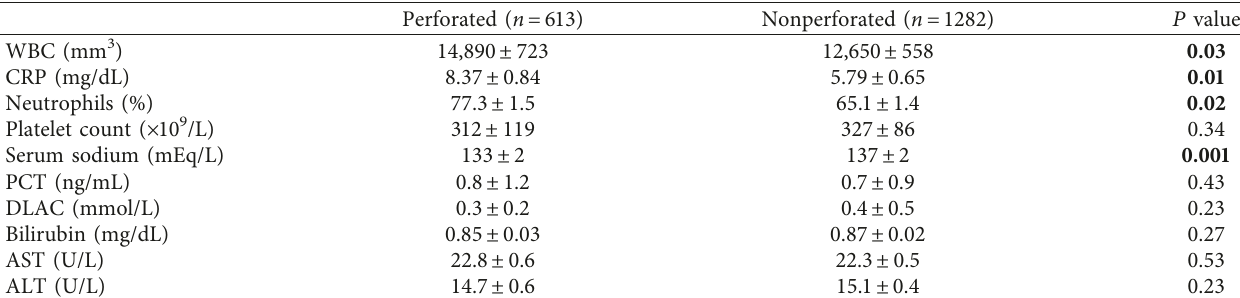
Table 3: Laboratory markers in children with acute appendicitis.